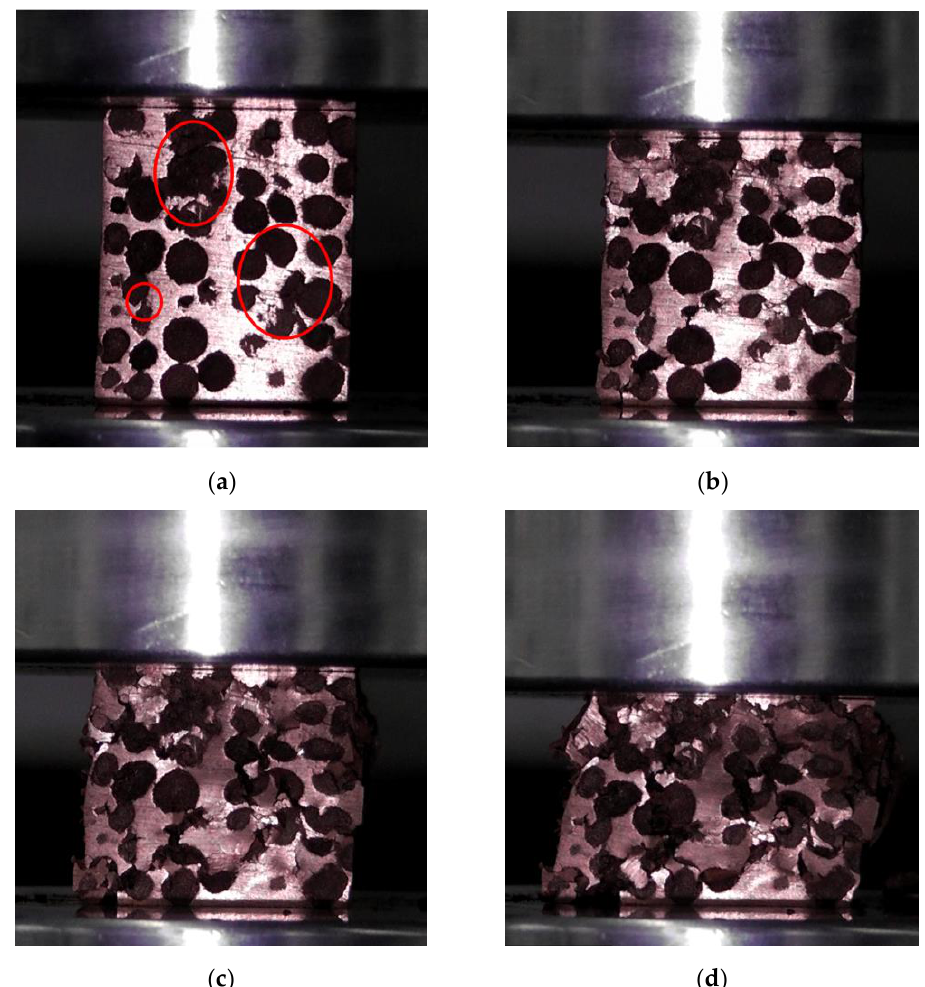
Figure 8. Deformation snapshots of the uniform CCCF with a pore diameter of 5 mm in the compression process. Some initial damages induced by the wire-cut electric discharge machining are marked by the red circles in ( a ). ( a ) ε = 0; ( b ) ε = 0.1; ( c ) ε = 0.2; ( d ) ε = 0.3.